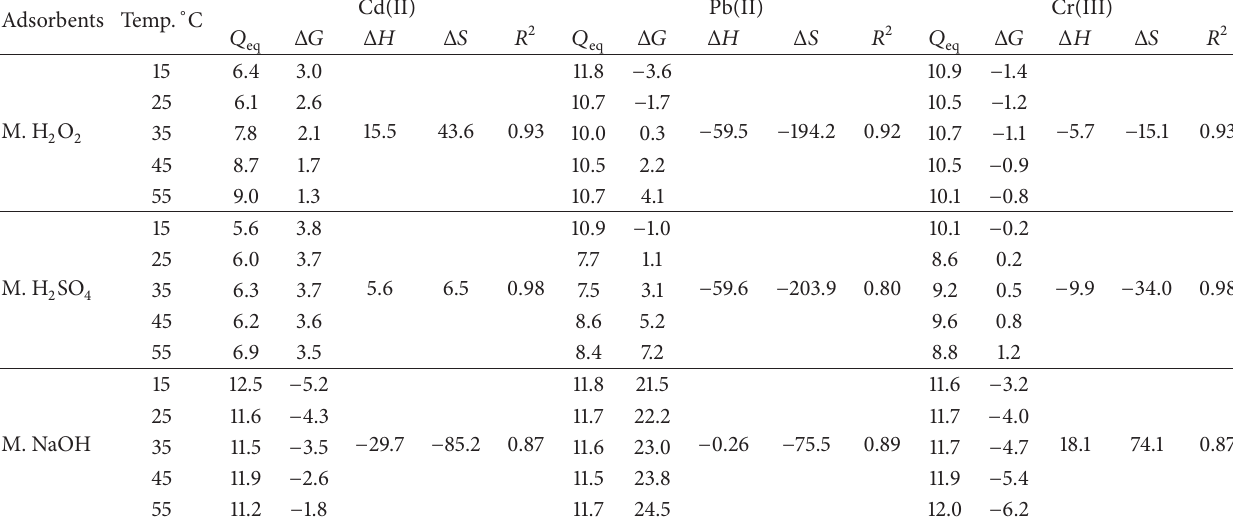
Table 9: Thermodynamic parameters for modified adsorbents from cassava peels in the removal of Cd(II), Pb(II), and Cr(III). Adsorbents Temp. ∘